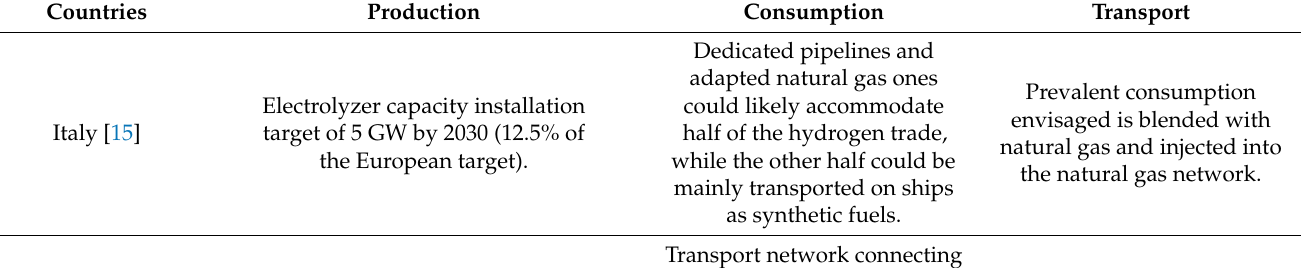
Table 6. Comparison of low-carbon hydrogen strategies of EU